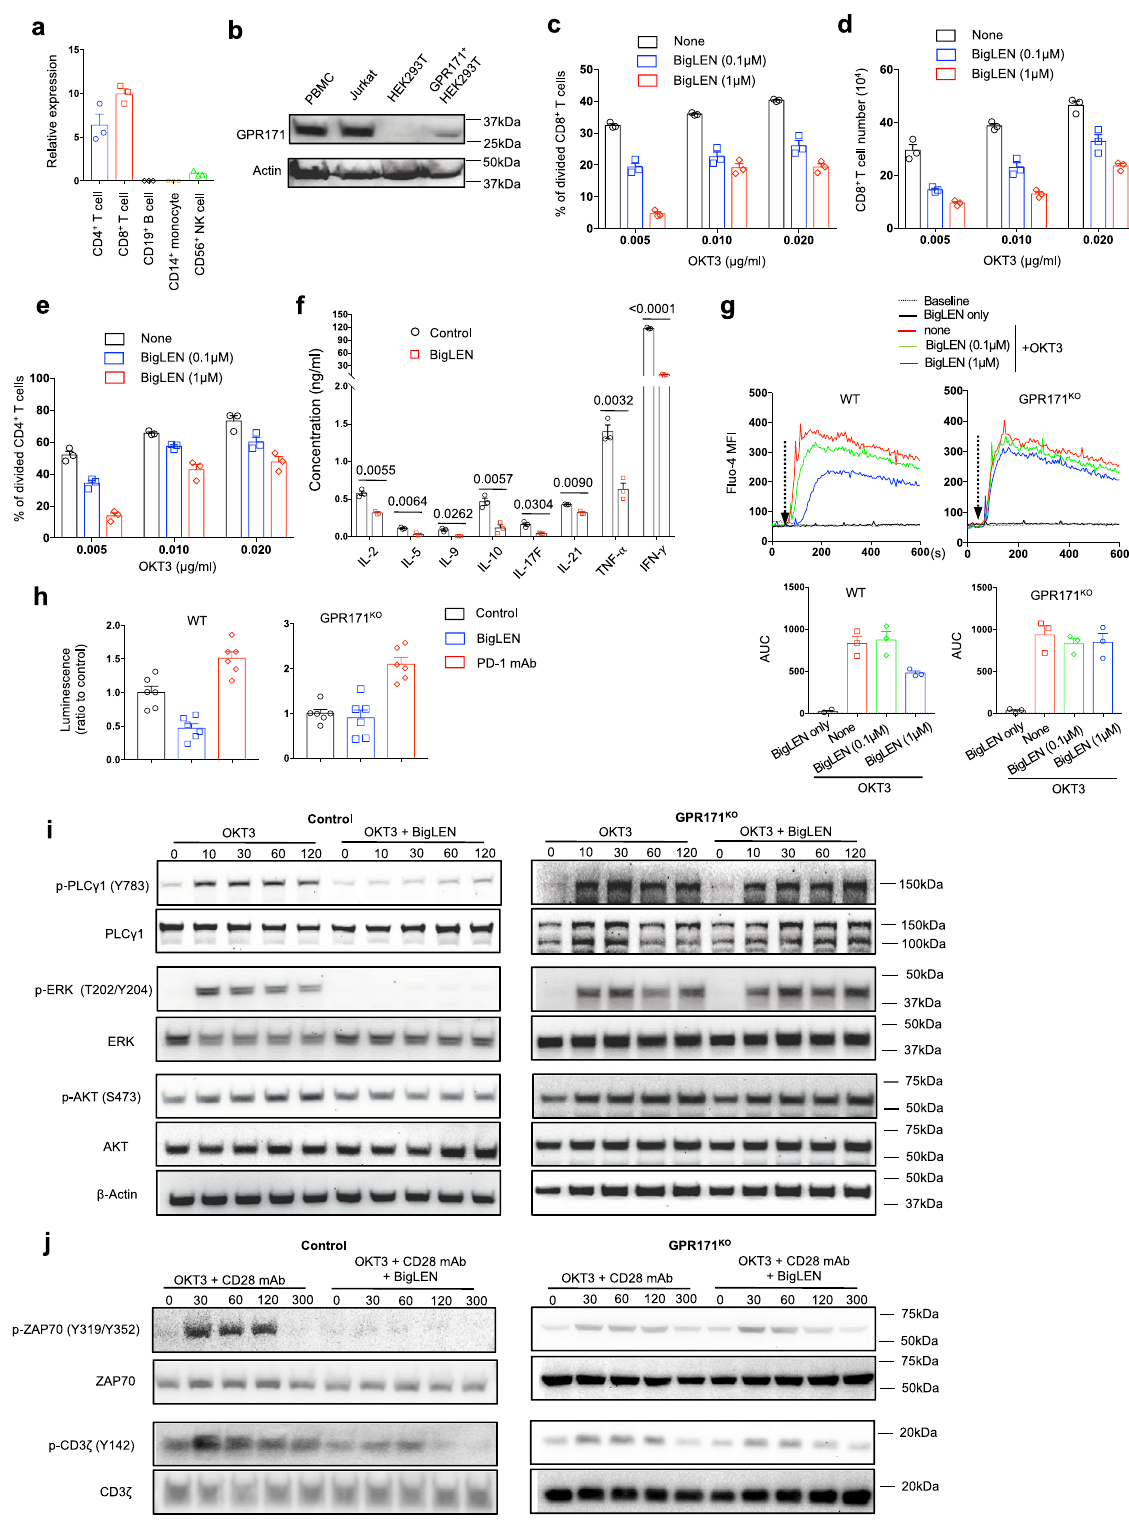
induced T-cell anergy model 33 , we transferred CD45.1 + OT-1 T cells into B6 mice and intravenously challenged with OVA257- 264 peptide. Peptide administration alone led to a dramatic expansion of transferred OT-1 T cells on day 4 and then a quick contraction on day 7; more transferred OT-1 T cells were constantly detected in peripheral blood when GPR171 antagonist was administered at the beginning of peptide inoculation (Fig.